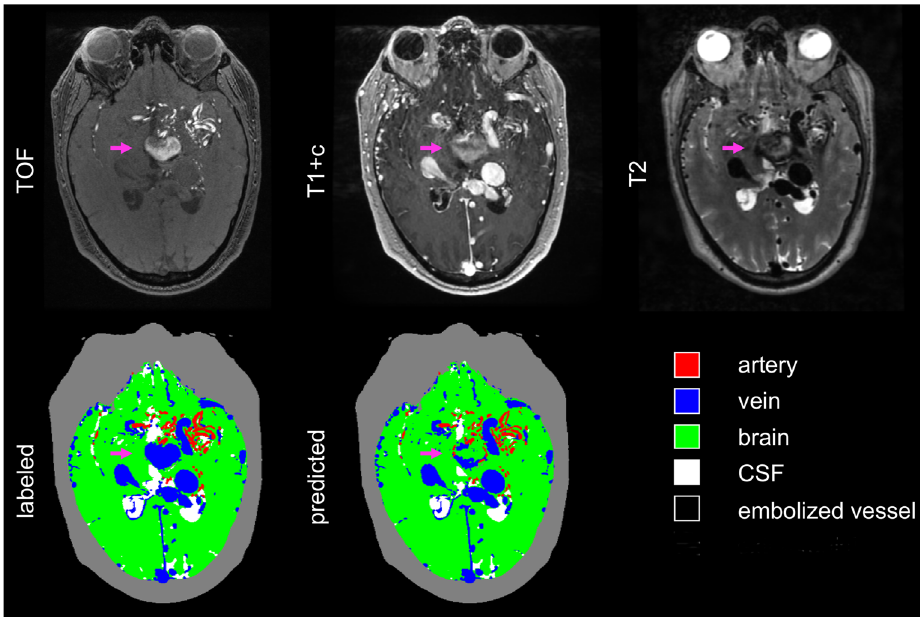
Figure 4. Representative images demonstrating misclassification within a thrombosed draining vein. Purple arrows show the location of the thrombosed vein which lacks characteristic flow-voids on T2, enhances poorly on T1 + c, and is bright on TOF. The neural network misclassifies portions of this vessel as brain parenchyma or artery. Dice similarity coefficients for this slice are as follows: arteries 0.86; veins 0.9; brain 0.96; CSF 0.74; embolized vessels 0 (not present). The grey contour outlining the extracranial space is not generated by the segmentation algorithm and is included for visual reference only. T1 + c: T1 post-contrast; TOF: time-of-flight. CSF: cerebral spinal fluid.